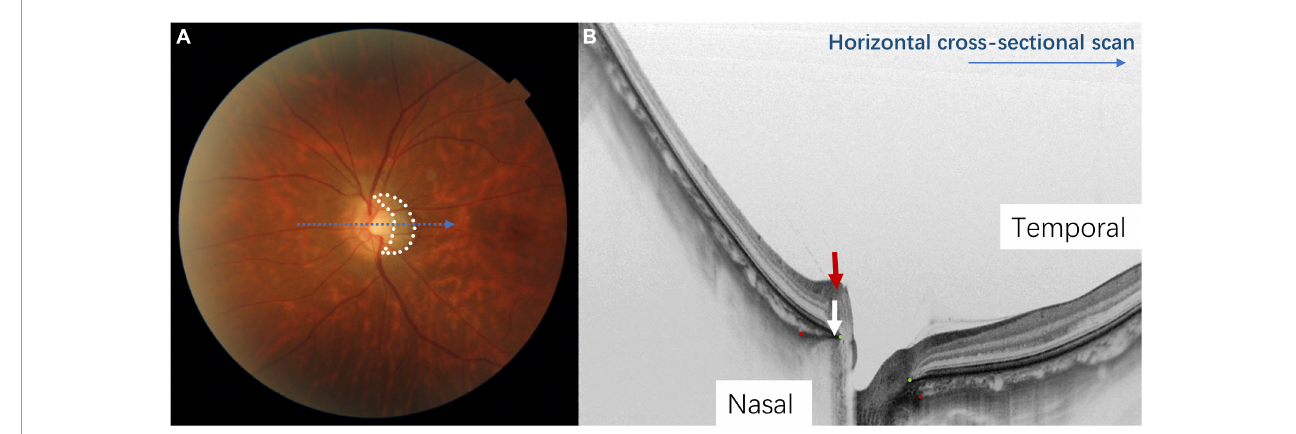
FIGURE2 The appearance of a myopic tilted disc on fundus photography and optical coherence tomography (OCT). Panel (A) shows a half-moon or C-shaped crescent (circled in white dots) around the optic disc. Panel (B) shows the tilted disc on a horizontal cross-sectional OCT scan (corresponds to the blue arrow in Figure 1A ). The Bruch’s membrane opening is shown by the green dots and the red dots indicate the anterior scleral opening. The nasal border of the optic disc is elevated, and the Bruch’s membrane-choroid complex (indicated by the white arrow) protrudes toward the optic disc, indicating temporal tilting of the optic disc. The nerve fiber layer on the nasal side of the optic disc is elevated (indicated by the red arrow), which also indicates that the optic disc is tilting toward the temporal direction.